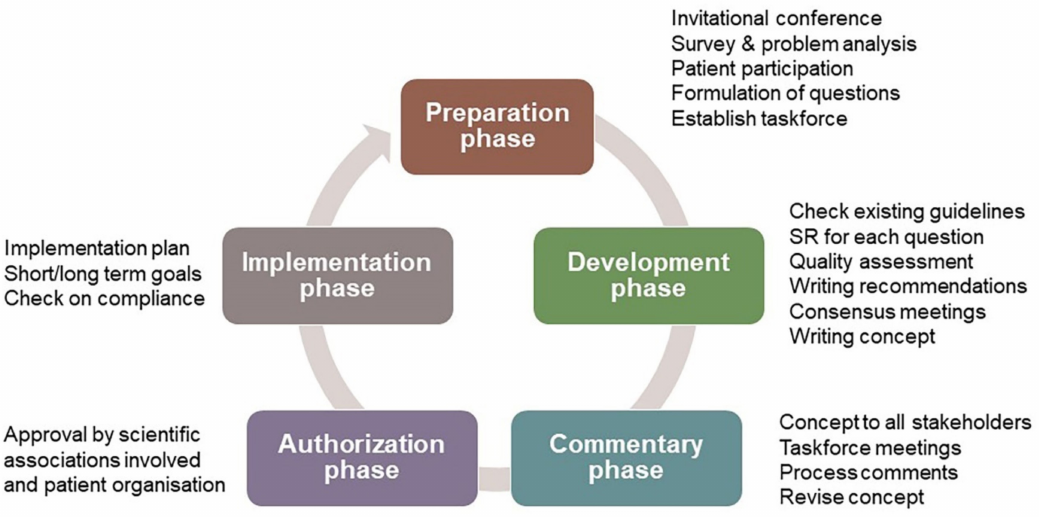
Figure 1. Overview of the phases of CPG